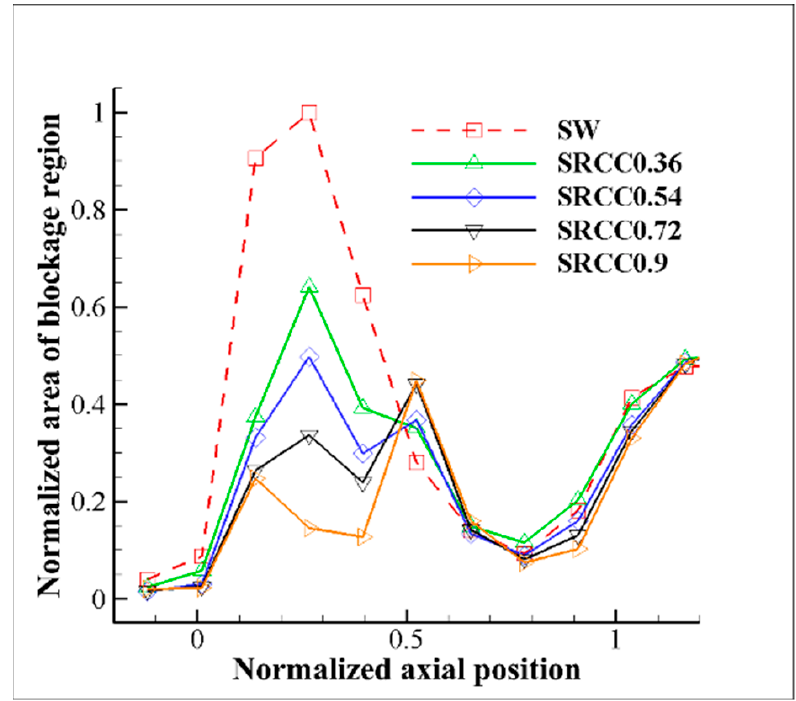
Figure 19. Distribution curve of the blocked area of the blade tip channel along the axis.